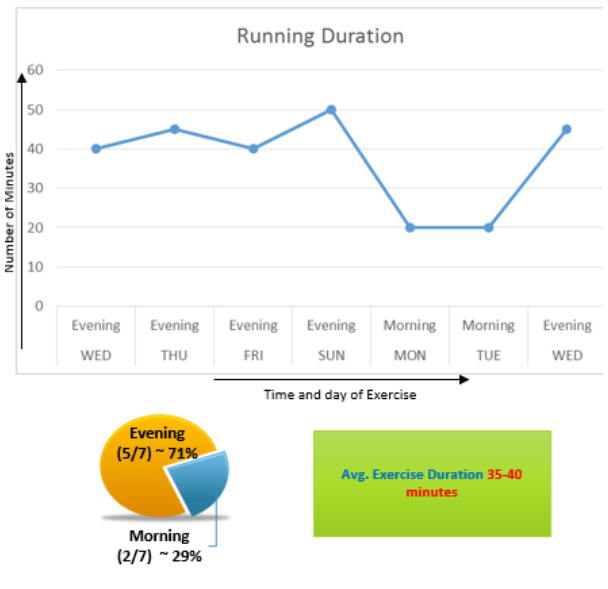
Figure 5. Visualization of favorite time during